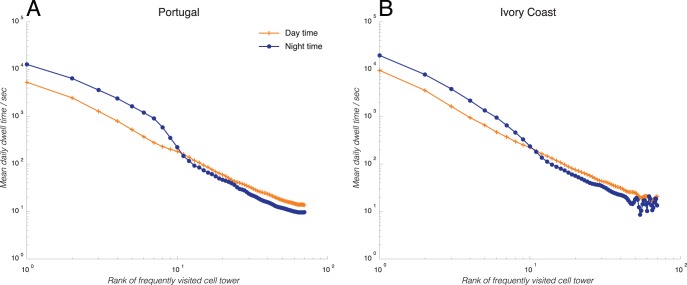
Range of mobility during day and night.This is quantified by the mean daily dwell-time that an average individual in Ivory Coast (right plot) and Portugal (left plot) spends in each of his/her ranked places in the set of non-overlapping frequented places, plotted on a log-log scale, during the day (solid red lines with crosses) and during the night (dashed blue lines with open circles). While the daytime curves follow roughly Zipf’s law, the nighttime curves show a distinct sigmoidal behavior.